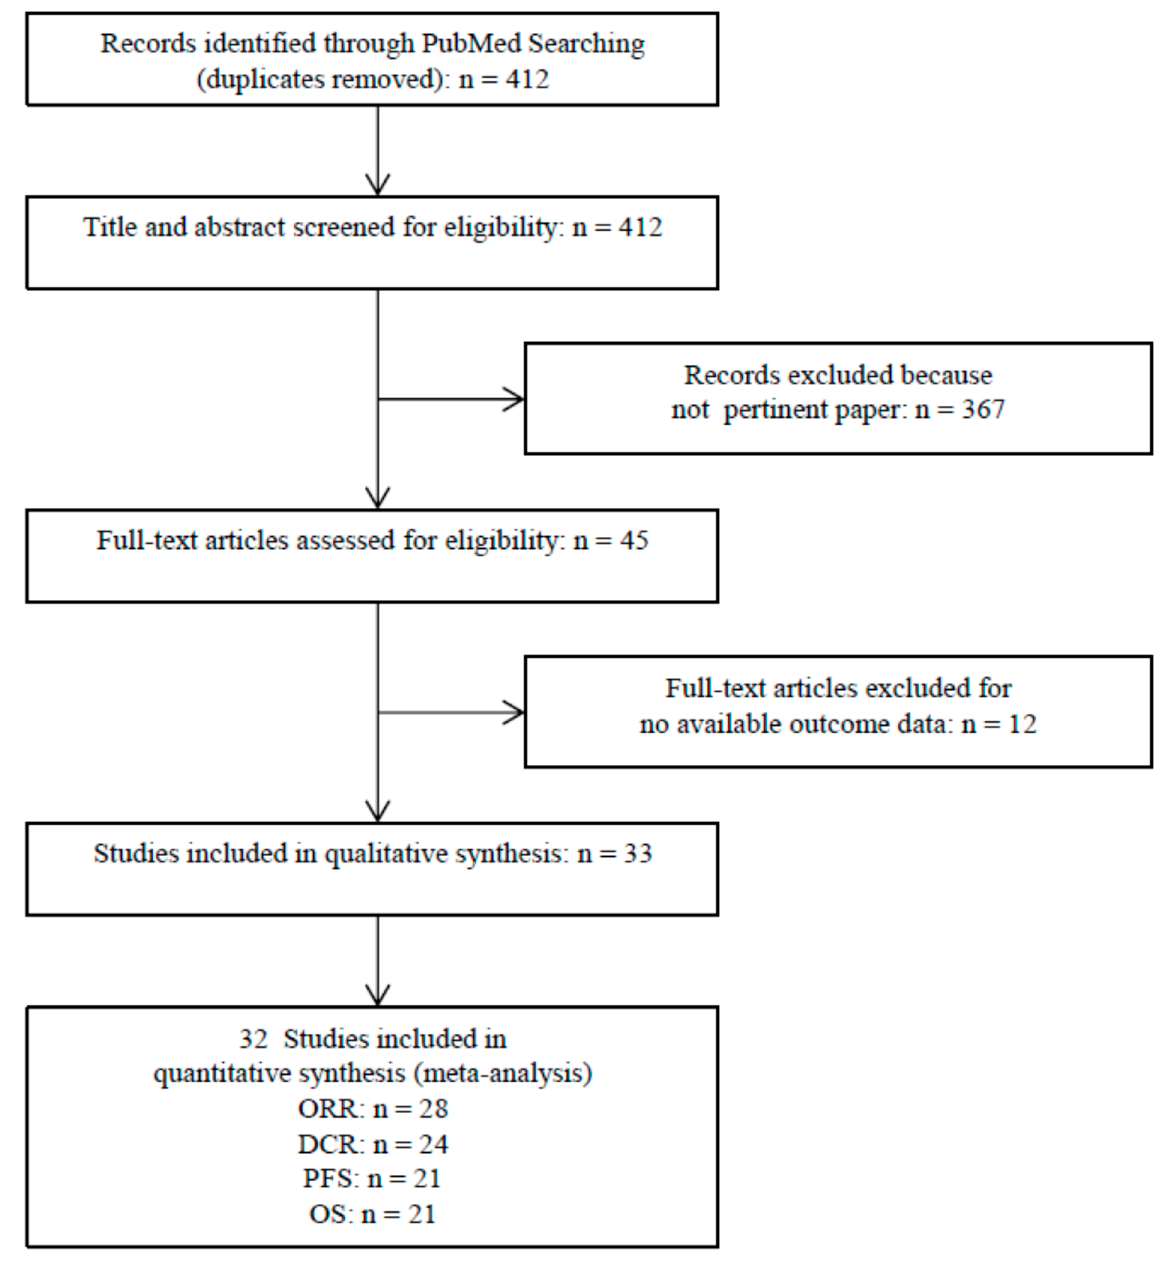
Figure 1. Flow chart of study selection and design.